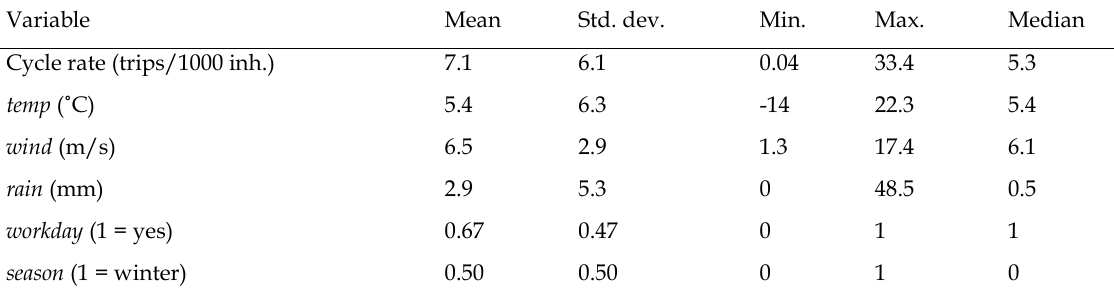
Table 1. Descriptive statistics (1,366